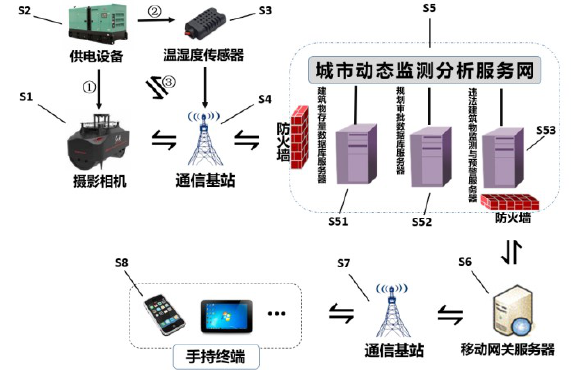
Figure 3. Schematic diagram of data transmission for